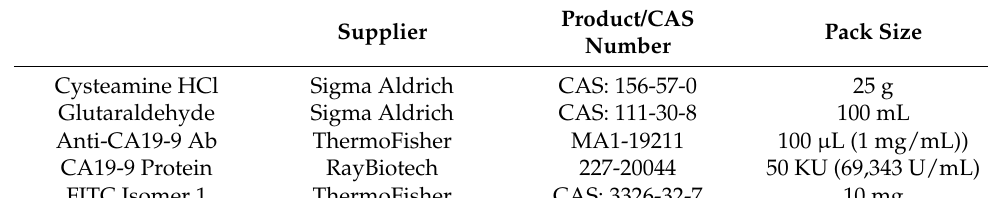
Table 1. Reagents and proteins used for all incubation steps.